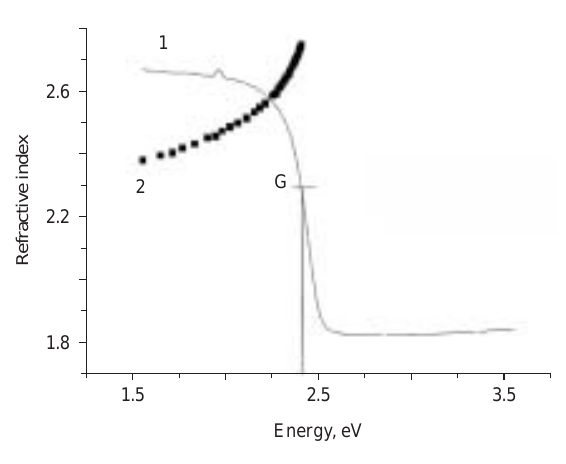
Fig. 12 Comparison of the variations of refractive index for nano- materials CdS(14 wt. %)-PTFE nanogranules (1) and for bulk crystal of cadmium sulfide (2).